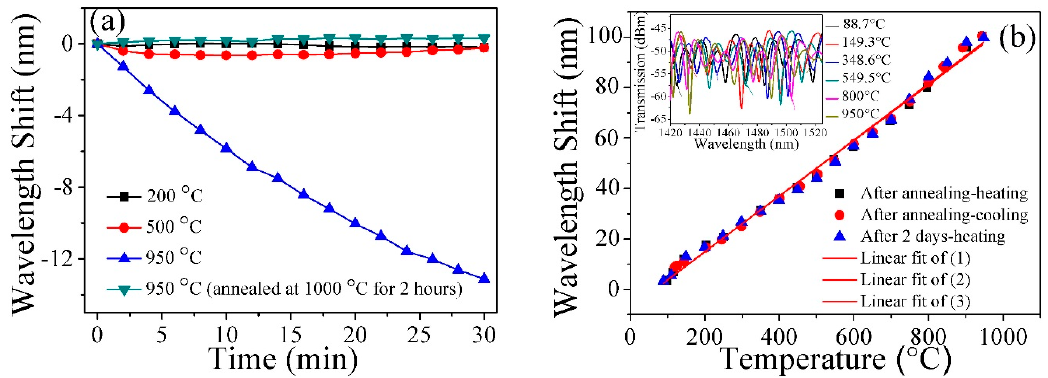
Figure 9. ( a ) Probe-type MZI-based sensor (B = 2 cm) stability test; ( b ) wavelength shift of the sensor